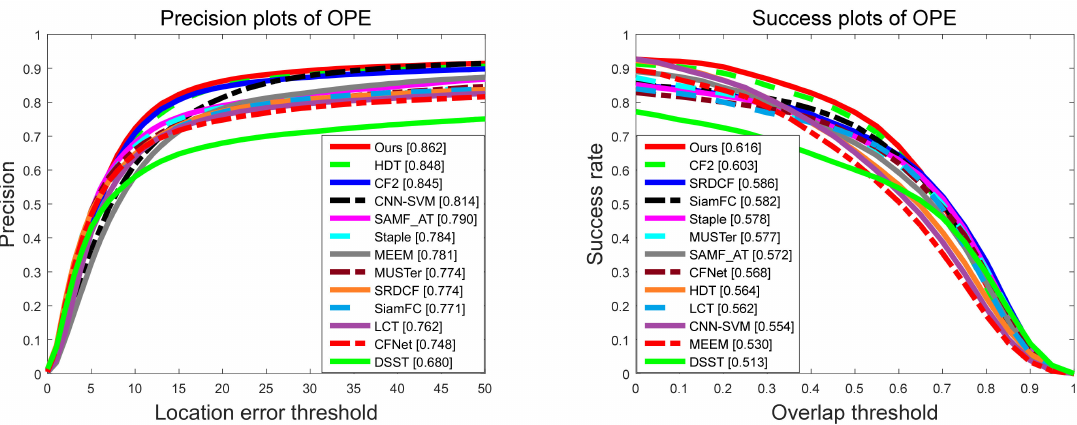
Figure 7. Precision and success rate of our proposed tracker and compared other 12 trackers on